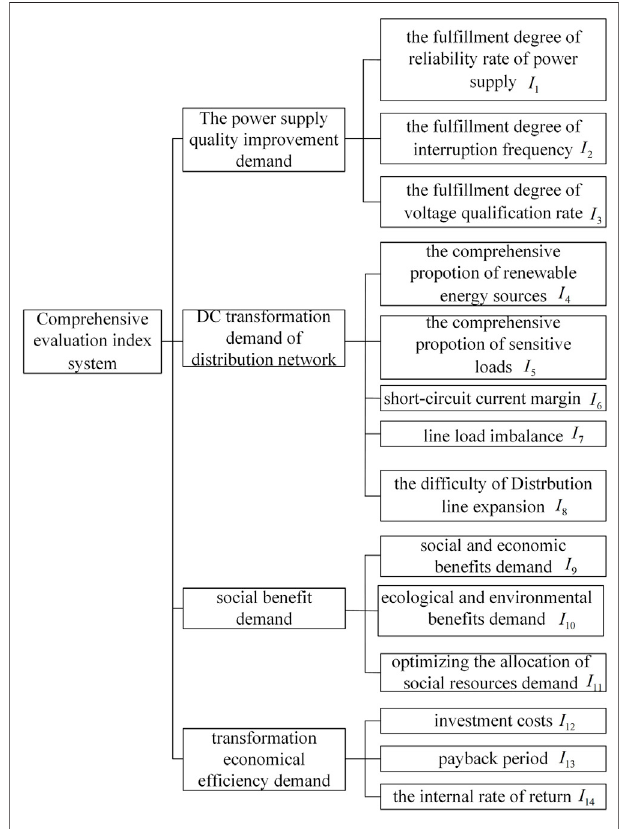
FIGURE 1 | Comprehensive evaluation index system of DC transformation object of the urban distribution